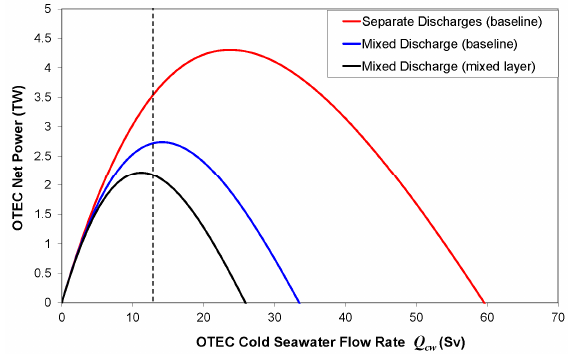
Figure 3. Steady-state OTEC net power as a function of overall cold seawater flow rate for baseline mixed (blue) and separate (red) effluent discharge scenarios, as well as for a mixed-effluent discharge into the mixed layer (black).